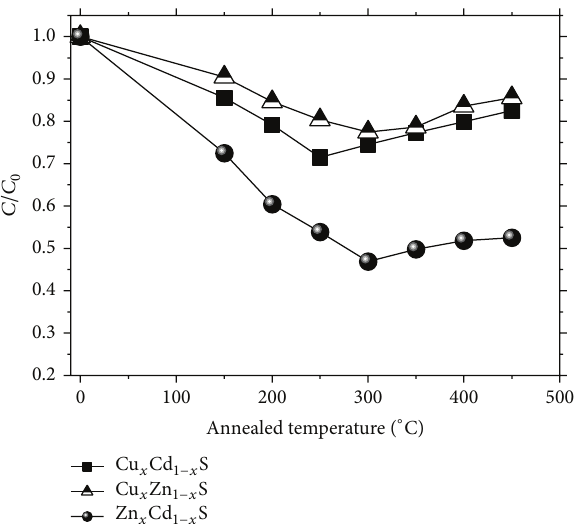
Figure 6: Photobleaching of the normalized concentration of MB after 3h as a function of the annealing